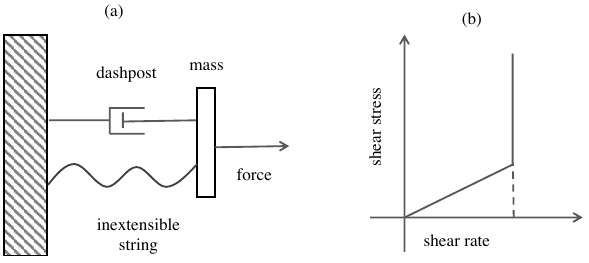
Figure 1. String-dashpot system ( a ) and constitutive law ( b